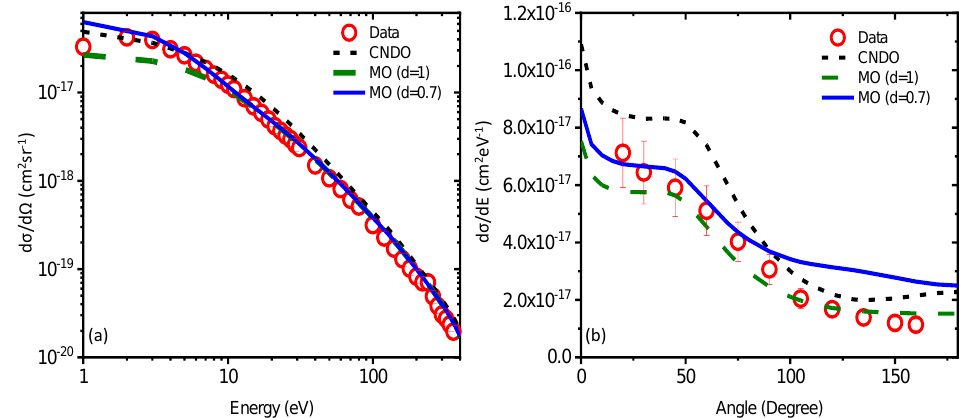
Figure 3. a and b represent the energy and angular distribution of SDCS, respectively, along with the theoretical